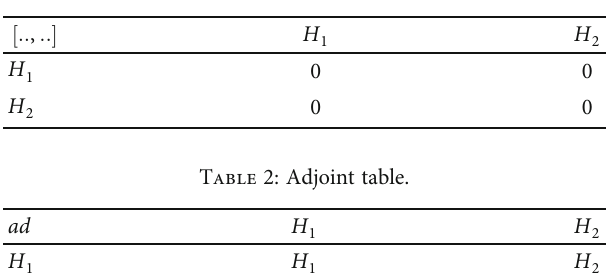
Figure 2: Schematic representation of the fl ow showing a fi lm fl owing vertically down. Table 1: Commutator table.